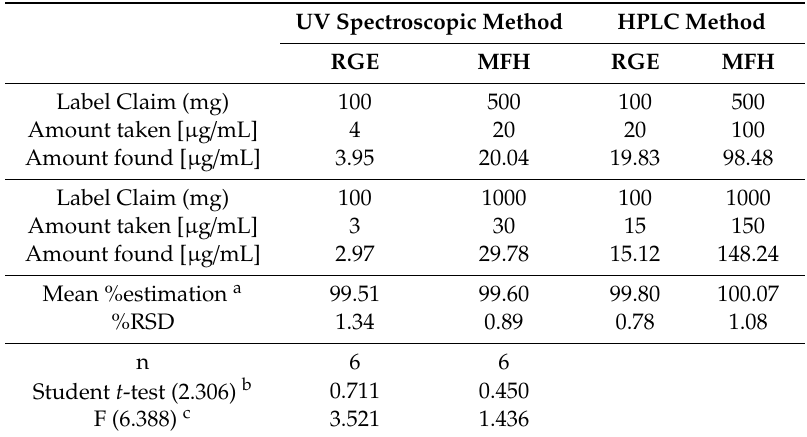
Table 7. Assay of formulation and statistical calculation